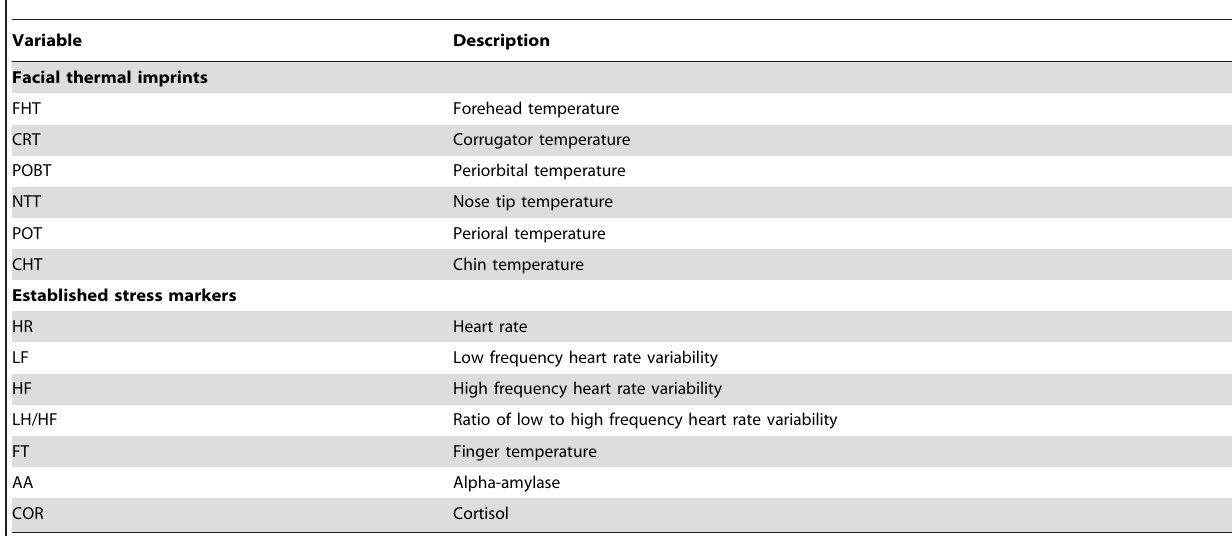
Table 1. Summary of the dependent variables.